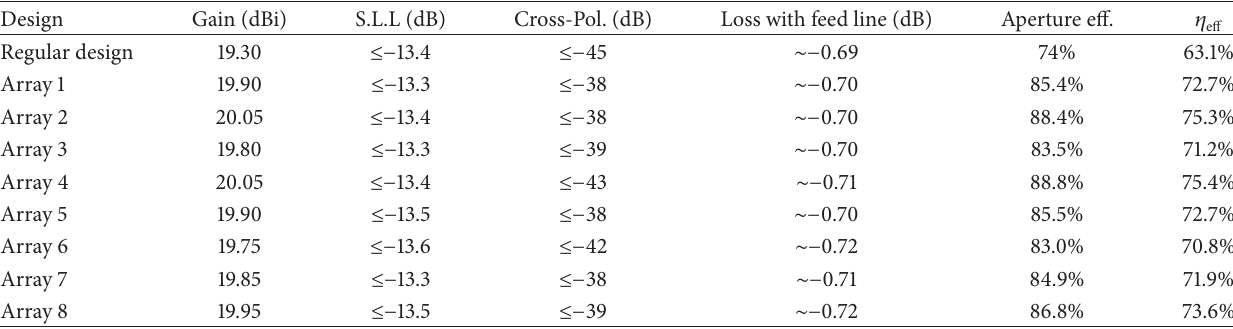
Table 1: Computed results of the